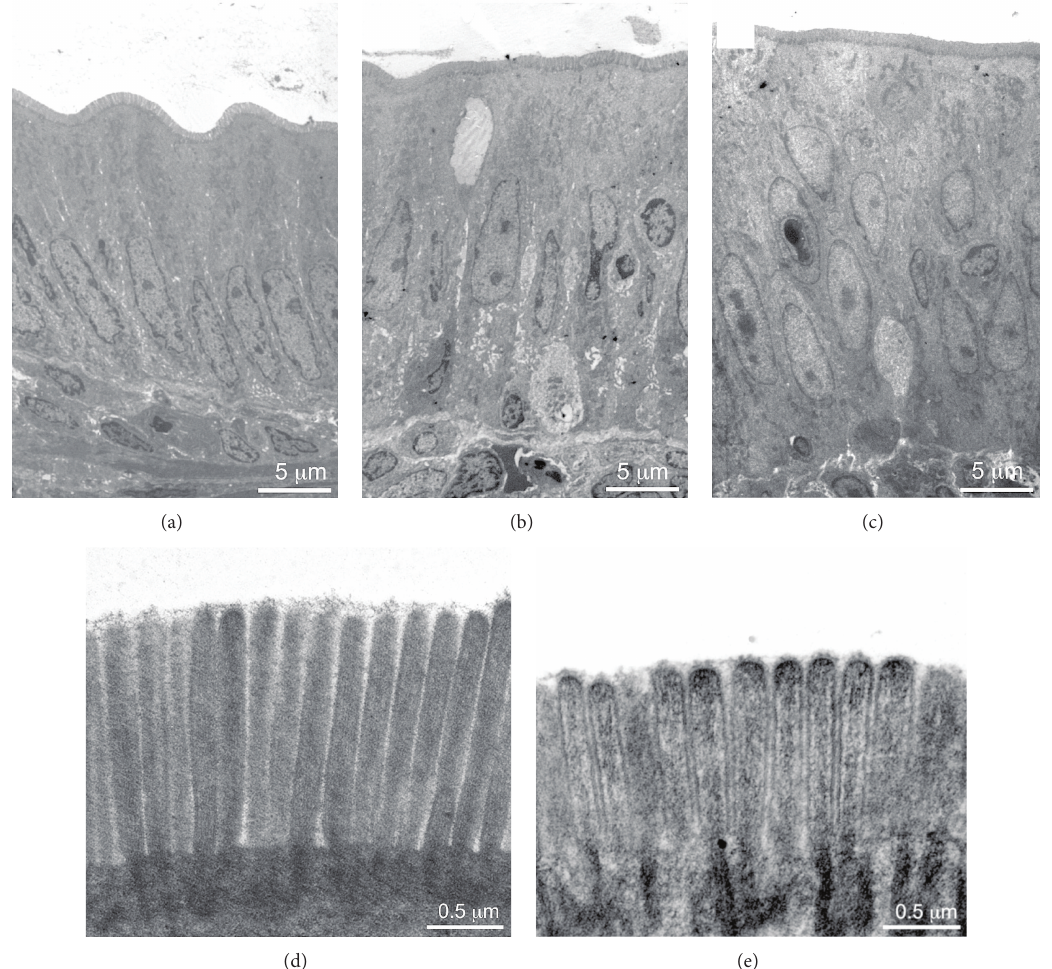
Figure 8: Electron microscopic appearance of the ileal epithelium of a sham-operated rat ((a), (d)) in comparison with the ileal epithelium of the interposed ileum ((b), (c), and (e)). The samples were taken in the 3rd week after sham or IIP surgery. (b) and (c) show epithelial layers of the interposed ileum with different degrees of hyperplasia; (d) shows microvilli of an epithelial ileal cell from a sham-operated animal; (e) shows microvilli of the luminal cell layer of interposed